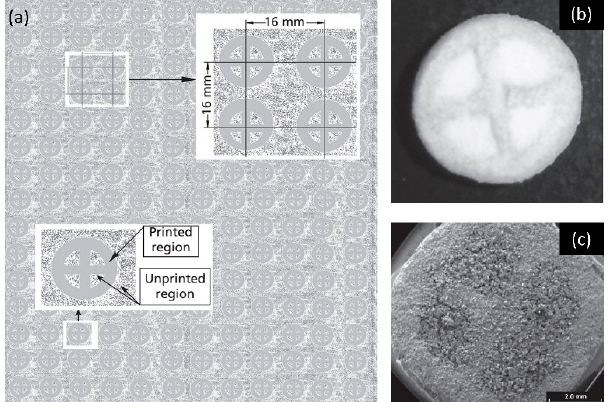
Figure 7. Example of fast-disintegrating drug delivery devices 3D-printed by PBBJ 3D-printing process. ( a ) computer-aided design model of fast-disintegrating drug delivery device. Reproduced